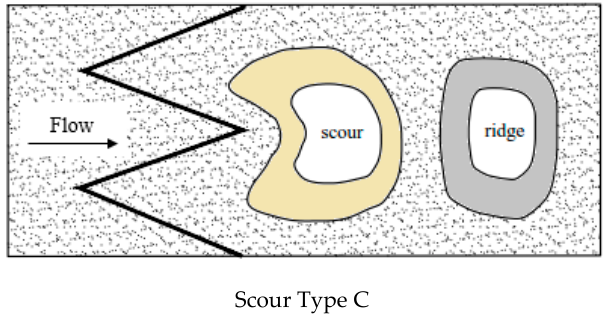
Figure 2. Different types of scour process downstream of W-weirs.